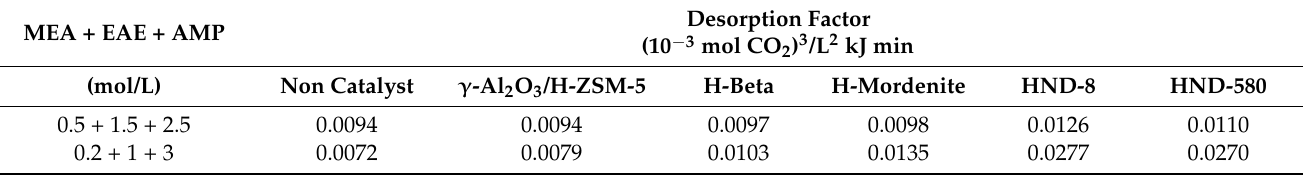
Table 4. The desorption factors of tri-solvent of MEA + EAE + AMP solvents with various catalysts at 30